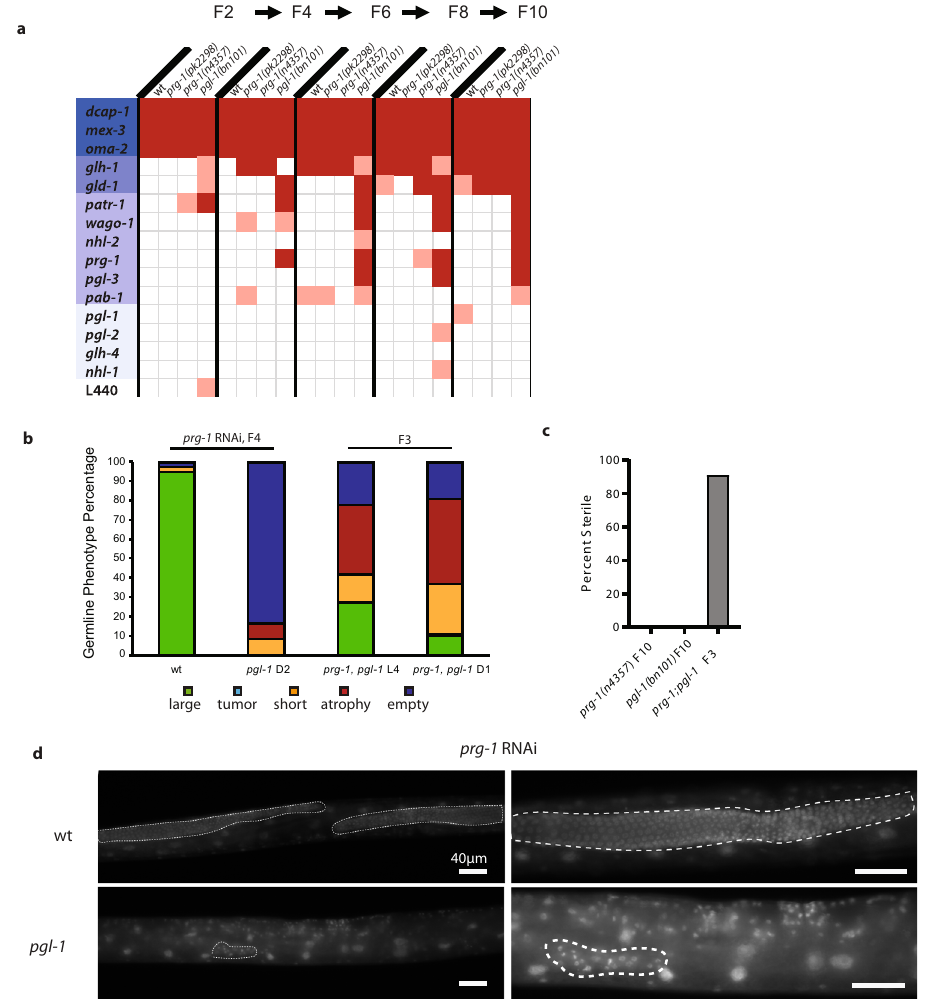
Fig. 6 De fi ciency for pgl-1 results in rapid sterility of prg-1 mutants. a Germline immortality assay with wild type, prg-1(pk2298), prg-1(n4357) , and pgl-1 (bn101) on different P granule RNAi clones. Two replicates of three L1 larvae were transferred every week or after two generations and plates were scored as sterile when no more than three worms were present after 1 week. Light red indicates sterility for 1 of 2 replicate plates while dark red indicates sterility for both replicates. When one plate became sterile, worms from the second plate were used for two replicates. Different shades of blue were used to visually group different RNAi datasets that showed a similar sterility pattern for wt, prg-1 , and pgl-1 worms. b Germline sizes of wild type and pgl-1(bn101) on prg-1 RNAi after four generations (wt n = 39; pgl-1 n = 12) and of prg-1; pgl-1 double mutant F3 animals ( n = 40); c prg-1; pgl-1 double mutants display marked sterility in the F3 generation. d Germline comparison after DAPI staining of wild type and pgl-1(bn101) on prg-1 RNAi after four generations. The germline arms are outlined with a white dotted line. While two germline arms could be detected in wild type that are large and visible throughout the body, only a small group of germ cells was detected in pgl-1(bn101) . At least 12 different animal germlines were examined in wild type and F4 pgl-1(bn101) on prg-1 RNAi, and representative images are